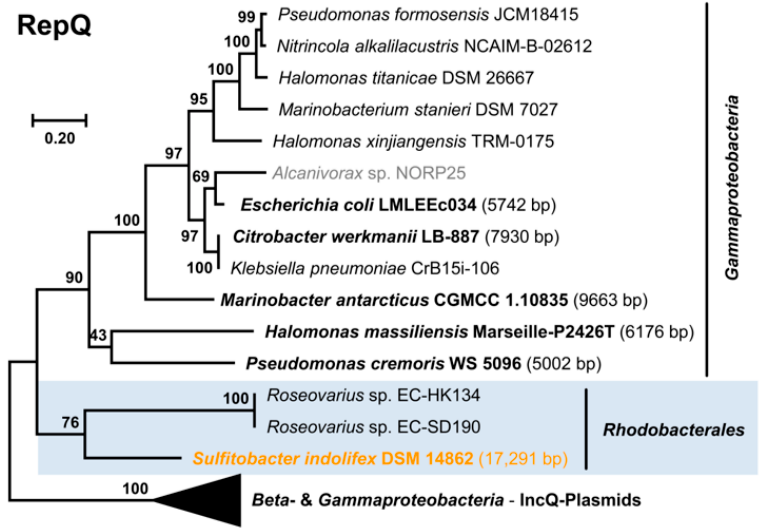
Figure 3. Phylogenetic Maximum Likelihood tree of 34 RepQ type plasmid replication proteins based on 266 amino acid positions. The replicase of Sulfitobacter indolifex DSM 14862 T is shown in orange, and replicases from metagenome-assembled genomes (MAGs) are shown in gray. Circular plasmids or circularized contigs are highlighted in bold. Sequences from Rhodobacterales are highlighted by a blue box. The complete tree is shown in Figure S6. Accession numbers, localization, and further characteristics of RepQ type plasmids are presented in Table S3A.